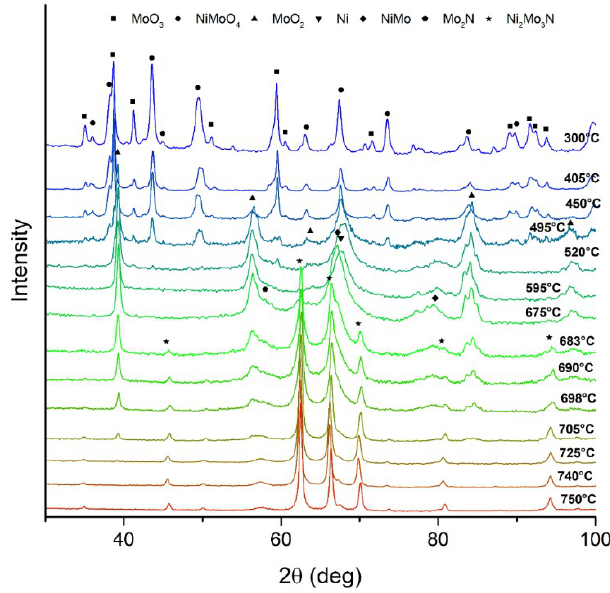
Figure 2. XRD patterns of samples heated to different temperatures in 100 mL/min 20% N 2 /H 2 flow.